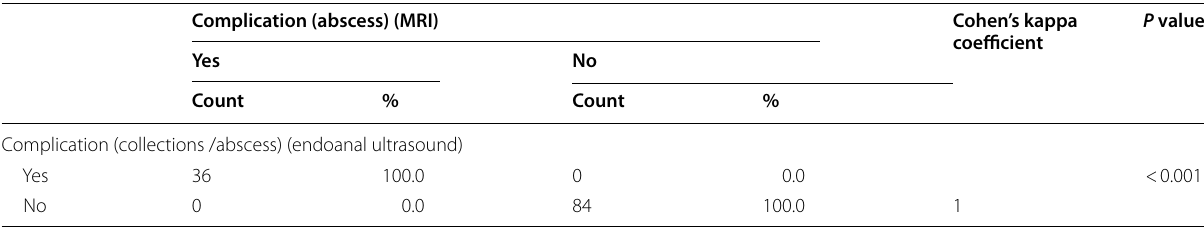
Table 5 Comparative study between endoanal ultrasound and MR in detection of complications Complication (abscess) (MRI)